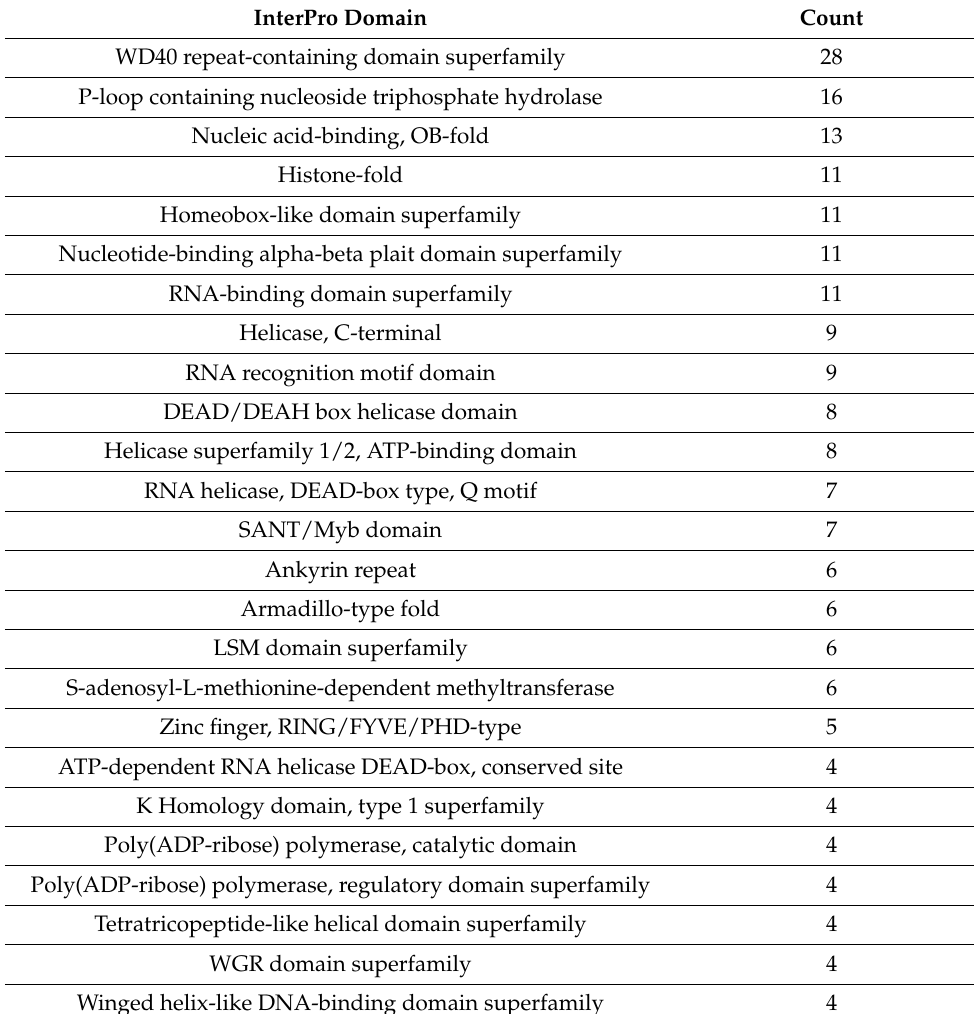
Table 2. InterPro domains found in MAC-enriched proteins . Domains that were found in at least four proteins are listed, with redundant domain entries removed. The complete list is provided in Supplementary Table